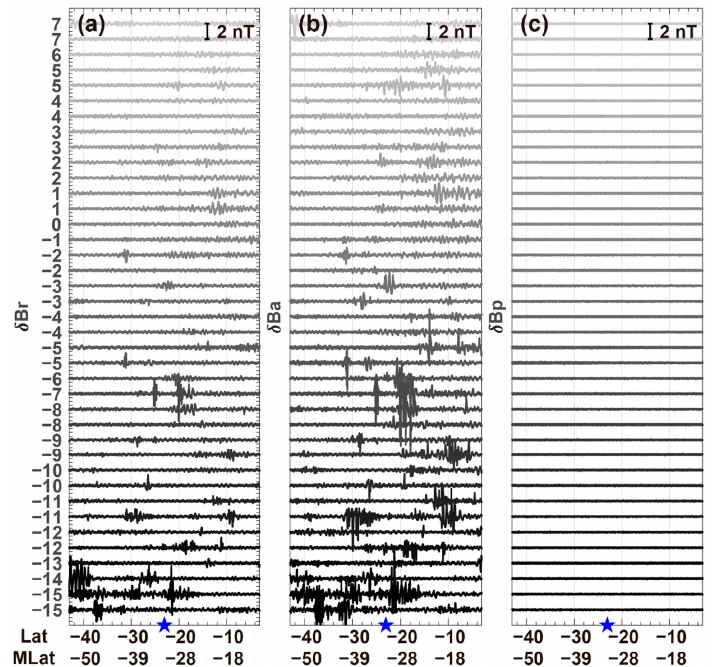
Figure 1. Magnetic disturbances observed by Swarm B 15 days before and 7 days after the M7.7 earthquake, and in the range of 20° latitude by 20° longitude centered on the M7.7 epicenter. ( a – c ) present the residual magnetic field in the radial, azimuthal and parallel directions. The stars on the horizontal axes indicate the epicenter’s latitude, and the y -axis shows the time differences ( Δ T in days) of each orbit relative to the day of the M7.7 earthquake.